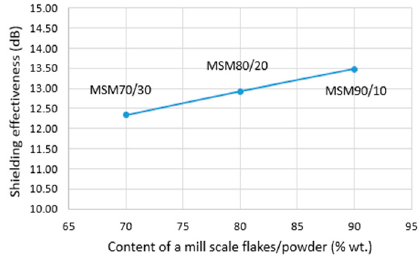
Figure 26. SE dependence of content of iron scale mix of flakes and powder. Frequency—10 GHz.